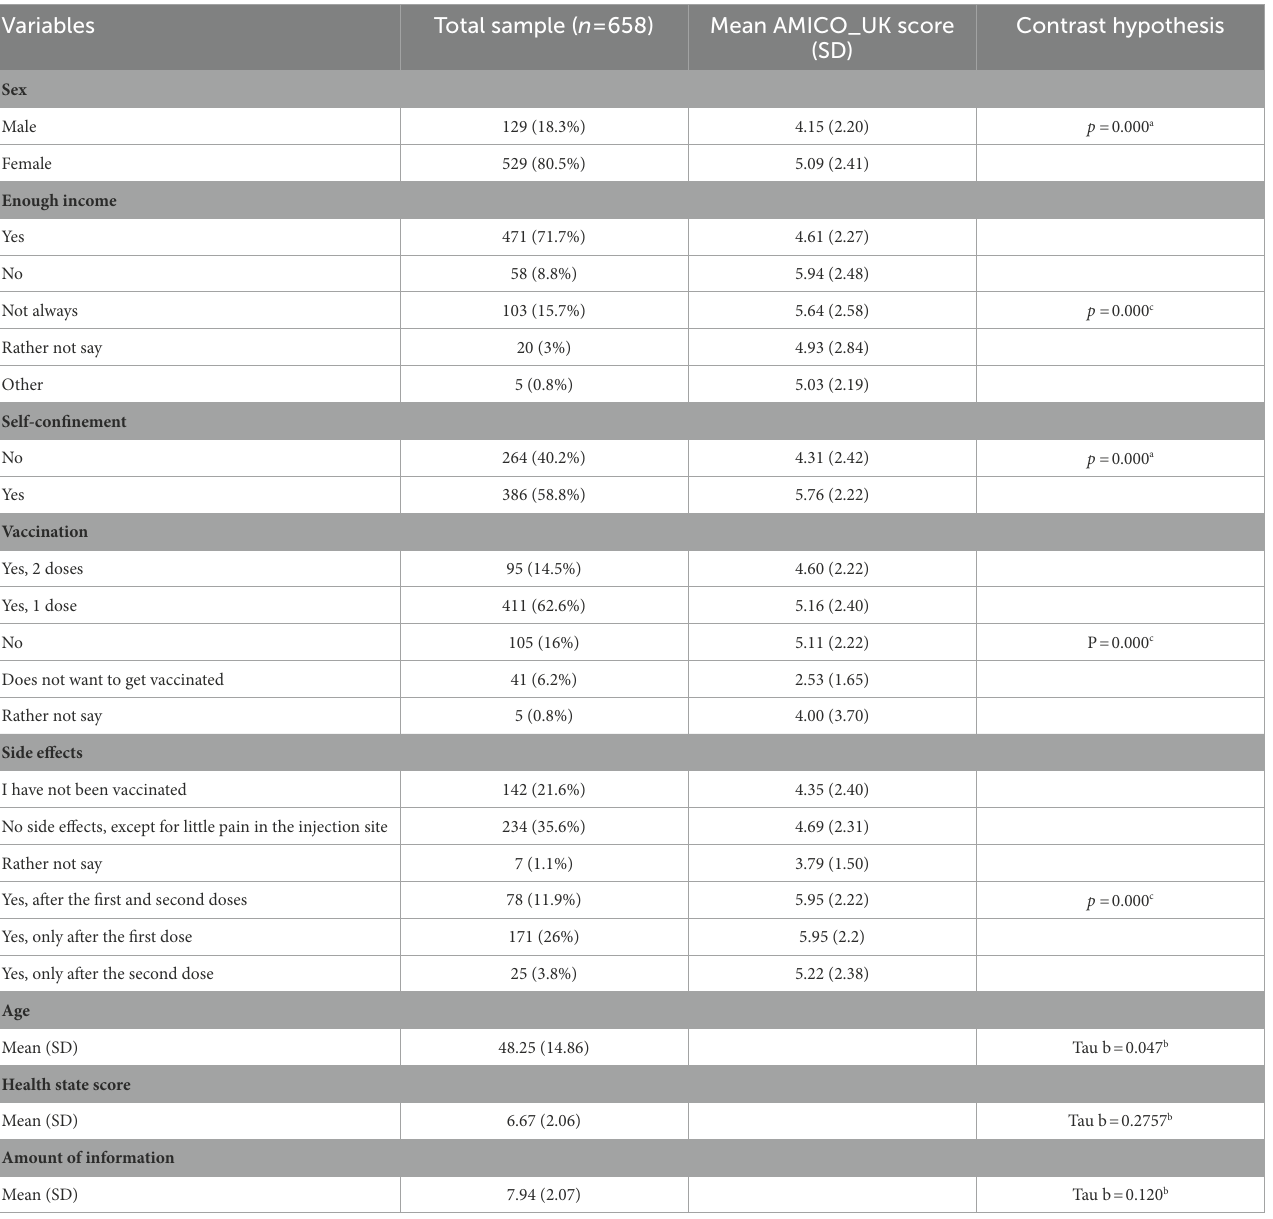
TABLE 1 Description of the sample